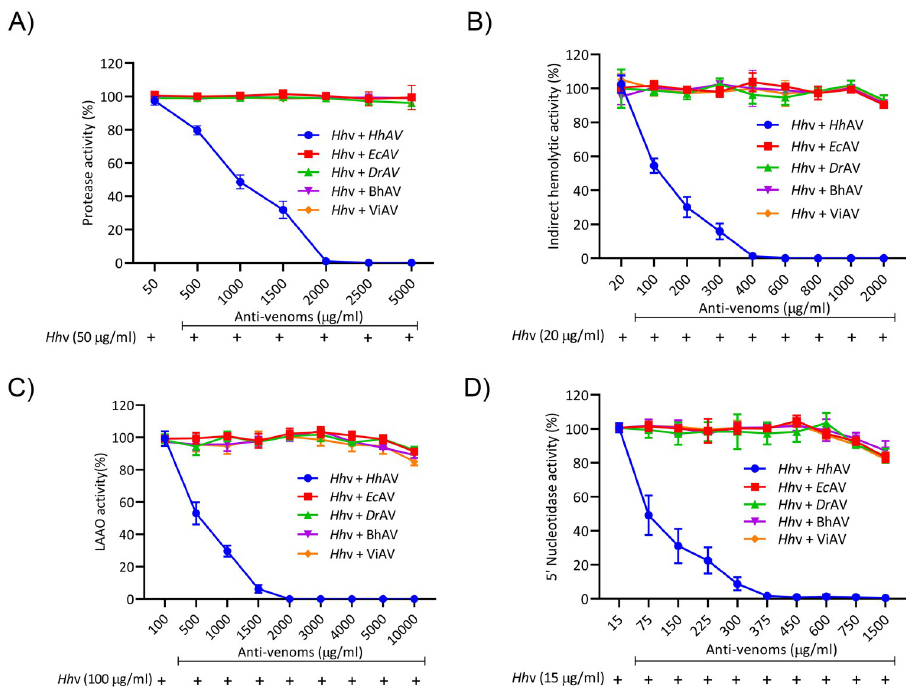
Fig 8. Neutralization of biochemical activities of H . hypnale venom by anti-venoms. (A) Proteolytic, (B) Indirect hemolytic, (C) L-Amino acid oxidase, and (D) 5’-Nucleotidase activities. Hh v was independently pre-incubated with various doses (50–10000 μ g/ml) of Hh AV, Ec AV, Dr AV, BhAV, and ViAV for 15 min at room temperature. Protease activity; 50 μ g/ml of Hh v alone was considered as 100% activity, hemolytic activity; 20 μ g/ml of Hh v alone was considered as 100% activity, L-amino acid oxidase activity; 100 μ g/ml of Hh v alone was considered as 100% activity, and 5’-Nucleotidase activity; 15 μ g/ml of Hh v alone was considered as 100% activity. The data is presented as Mean ± SEM (n = 3).